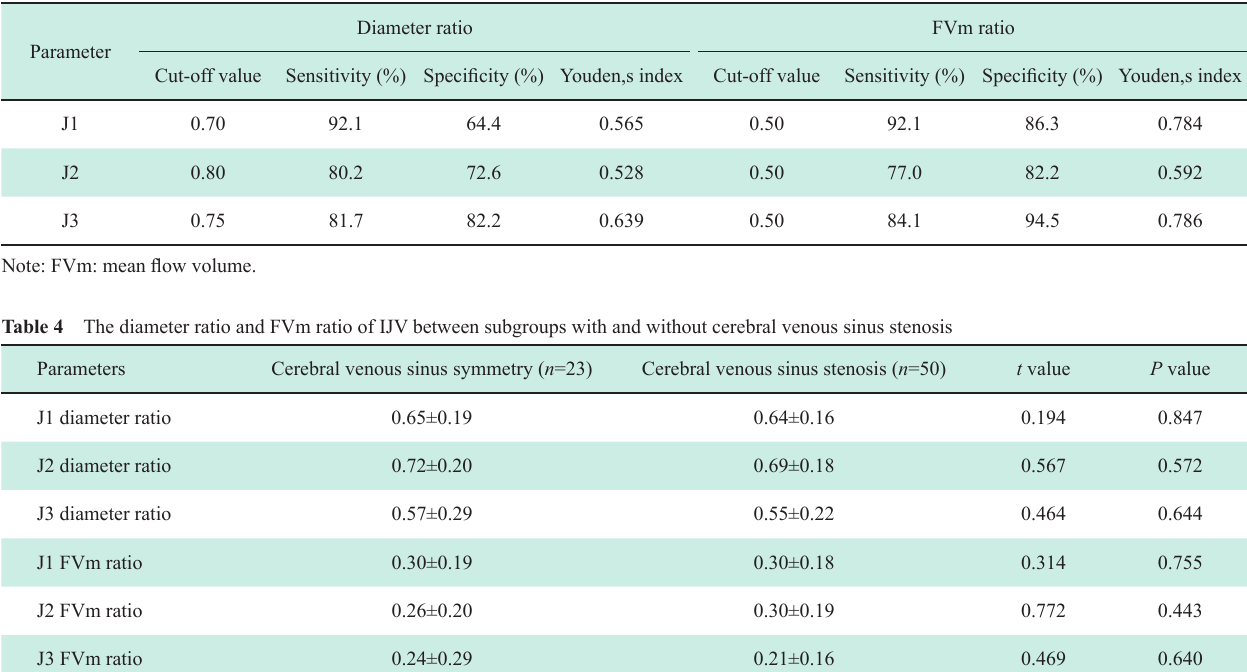
Table 3 The optimal cut-off values of diameter ration and FVm ratio for identifying IJV hypoplasia